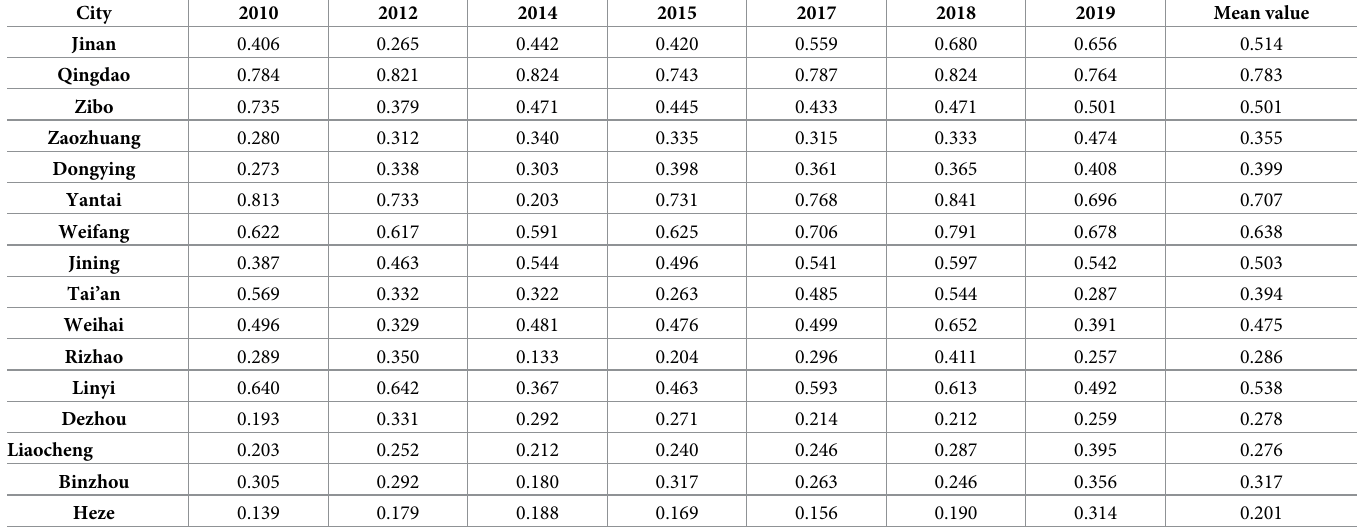
Table 2. Value of culture and tourism integration efficiency of 16 cities in Shandong Province from 2010 to 2019. City